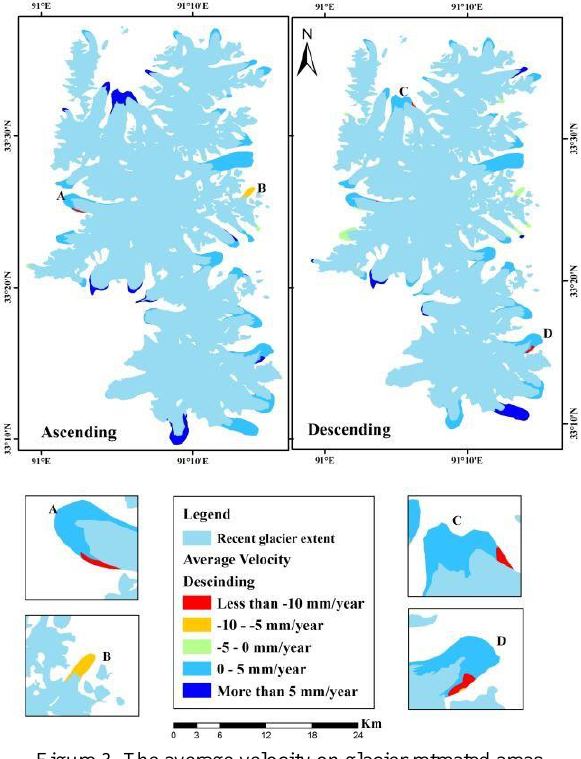
Figure 3. The average velocity on glacier retreated